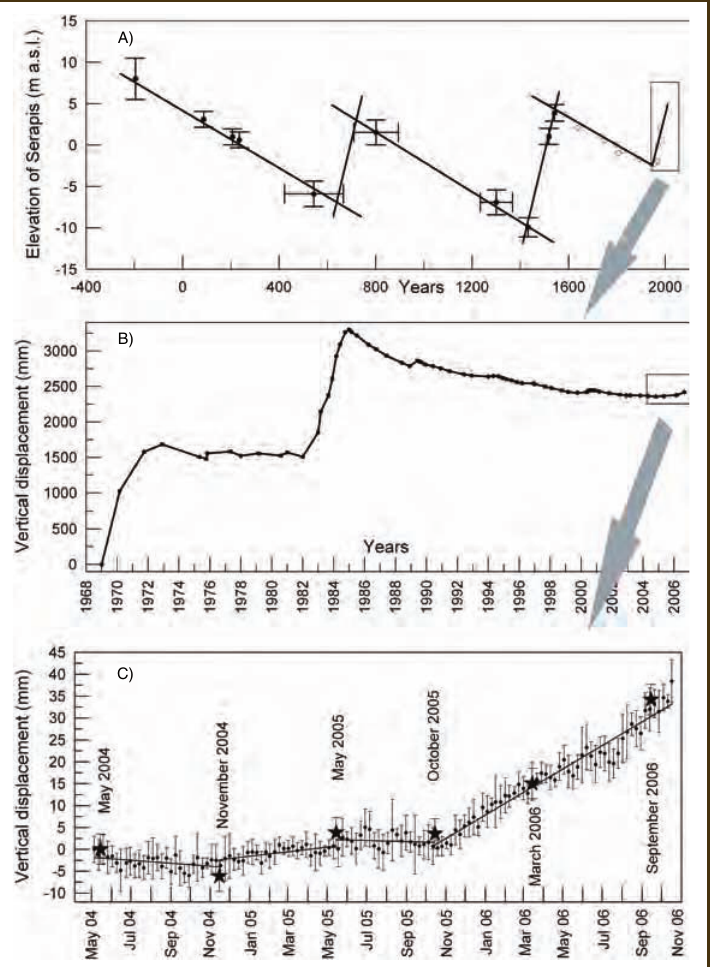
Figure 2. Ground deformation at Campi Flegrei as a function of time, at three progressive enlargements. [A] Schematic vertical movement history at Macellum in Pozzuoli, known as Serapis Temple. Black circles and white circles represent data points from various sources (see De Natale et al., 2006 and references therein). [B] Vertical ground displacements as recorded at Pozzuoli Harbor by leveling data during 1969–2006. [C] Detail of vertical displacement from May 2004 to October 2006 as recorded from CGPS (dots) and precision leveling at bench mark in Pozzuoli harbor (stars). Errors on CGPS and leveling data (1 σ ) are also shown (Redrawn after Troise et al.,